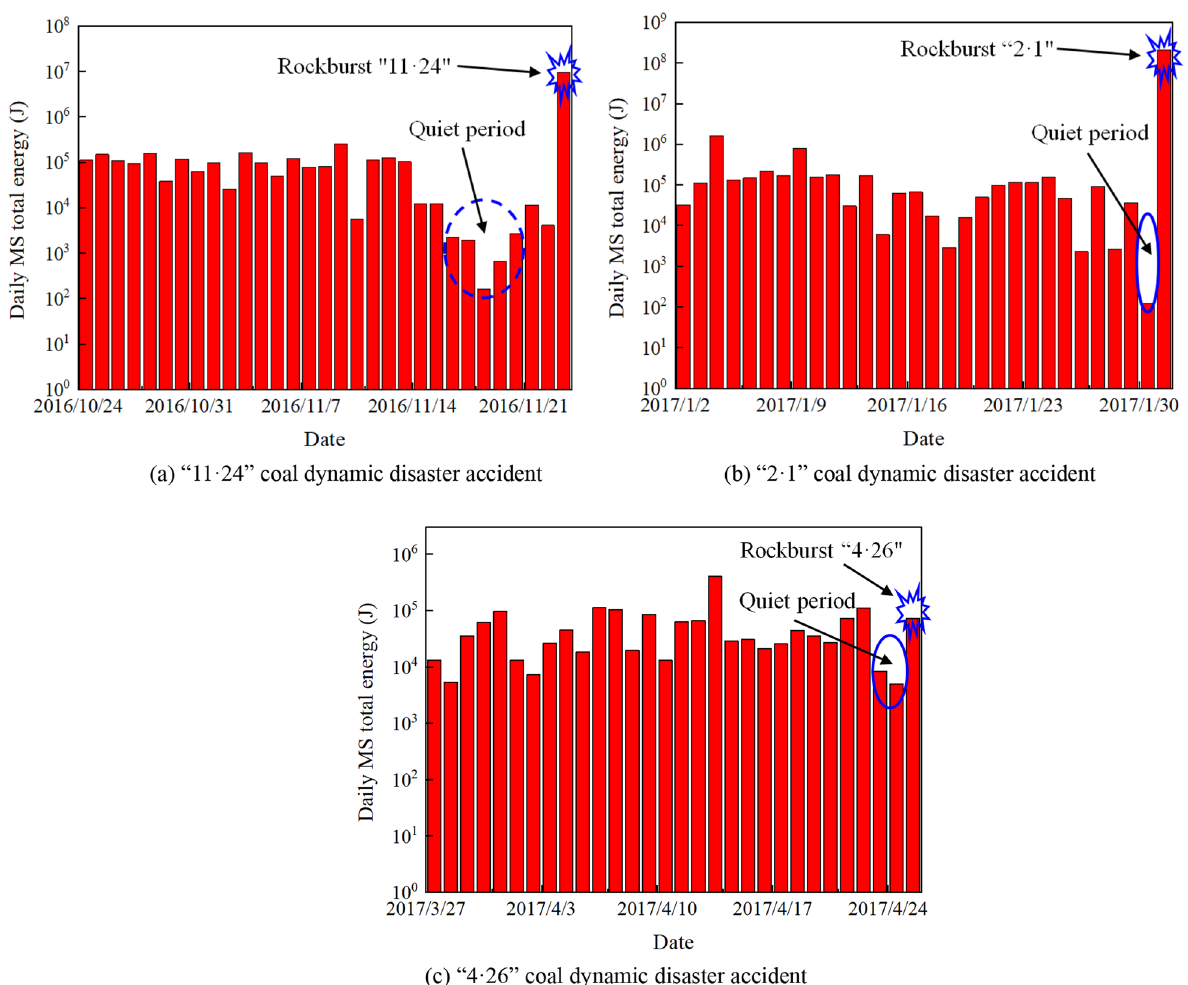
Fig. 6 Temporal evolution of daily MS total energy prior to coal dynamic disaster